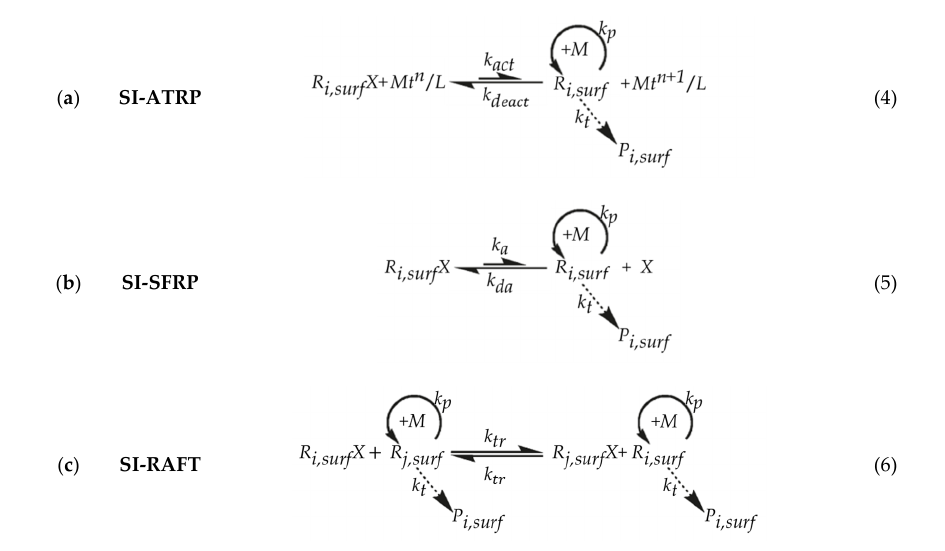
Figure 1. Principle of ( a ) surface-initiated atom transfer radical polymerization (SI-ATRP; Equation (4)) [28–33], ( b ) surface-initiated stable free radical polymerization (SI-SFRP; Equation (5)) [34–36] and ( c ) surface-initiated reversible-addition fragmentation chain transfer (SI-RAFT; Equation (6)) polymerization [37–41], depicting for simplicity only reactions on the surface (“surf”). In parallel, similar reactions can occur in the solution or between surface and solution species. In ( c ) the degenerative mechanism is depicted for simplicity while the initial radical source is not explicitly represented; surface-tethered active macroradicals with chain length i and j are represented as R i,surf and R j,surf , while surface-tethered dormant species are denoted as R i,surf X and R j,surf X . P i,surf stands for a surface-tethered dead chain with chain length i , and M represents monomer. Specific details ( a ) SI-ATRP: transition metal compound ( M tn / L ; activator; M tn : transition metal with oxidation state n ; L : ligand) and higher oxidation state metal complex ( M tn +1 / L ; deactivator); ( b ) SI-SFRP: stable free radical (X; typically nitroxide radical); k a/da : activation/deactivation rate coefficient; k tr : exchange “rate coefficient”; k p/t : propagation/termination rate coefficient.